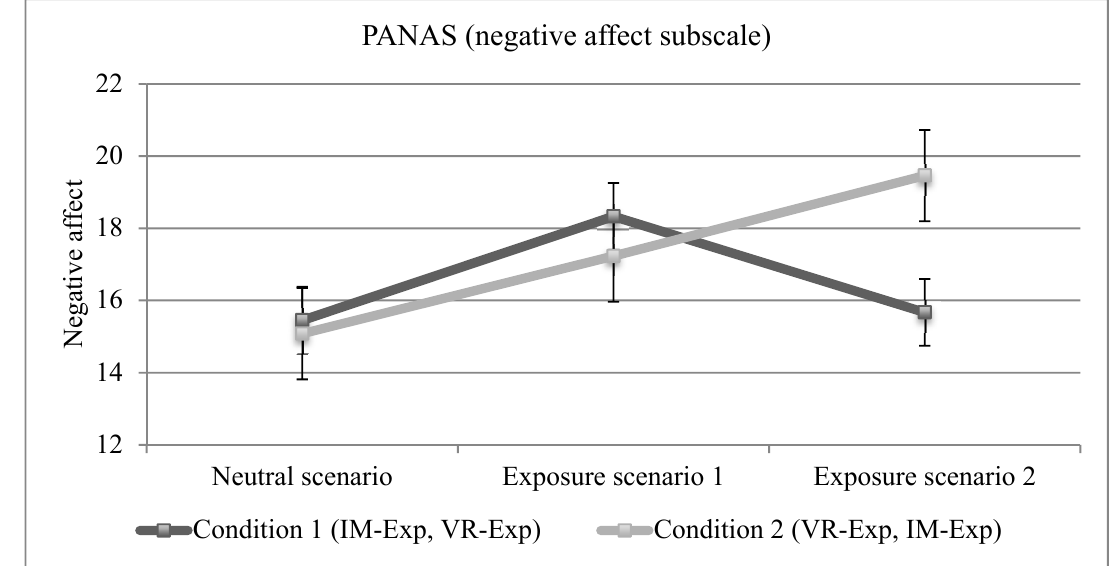
Figure 2. Illustration of the differential impact of exposure to a neutral scenario in virtual reality, a personalized scenario in imagination (IM-Exp) and a standardized scenario in virtual reality (VR-Exp) on the self-report measure of negative affect.